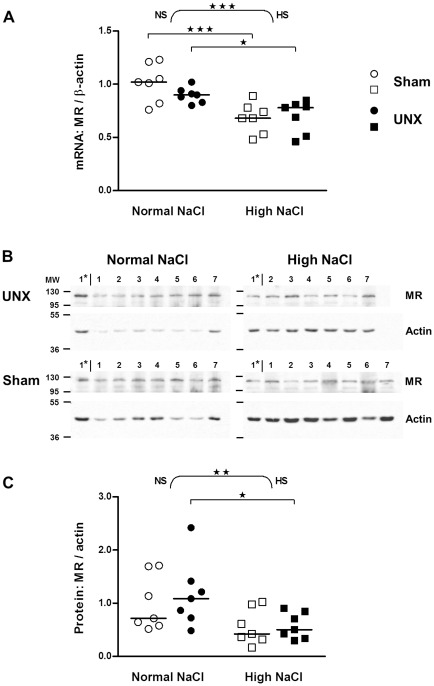
Impact of salt intake on mineralocorticoid receptor expression in the colon of control and UNX rats.A: mRNA expression in epithelial cells isolated from colon (real-time PCR). Values were normalized with endogenous β-actin mRNA expression. Results were quantified relative to the mean of the sham-operated, normal salt group. B: Western blots showing protein in epithelial cells isolated from colon. MR detection was done on the same membranes used for GR before (Figure 4). For reprobing membranes were incubated in stripping buffer (2% SDS, 62.5 mM Tris-HCl pH 6.8, 0.75% beta-mercaptoethanol in H2O) for 30 min at 50°C while shaking and washed three times in TBS-T. Lanes 1–7: Rat colon samples; Lane 1*: Sample 1 of UNX high NaCl group was loaded on each gel as a standard for comparison between blots; MW: molecular weight. C: Amount of proteins relative to control rats (sham-operated, normal salt). Bands quantified as in Figure 2. The horizontal line is the median (n = 7). ★, P≤0.05; ★★, P≤0.01; ★★★, P≤0.001 indicate the effect of salt by two-way ANOVA (curly brackets; NS: normal salt; HS: high salt) or significant differences between normal and high salt groups (squared brackets, Bonferroni's post test).